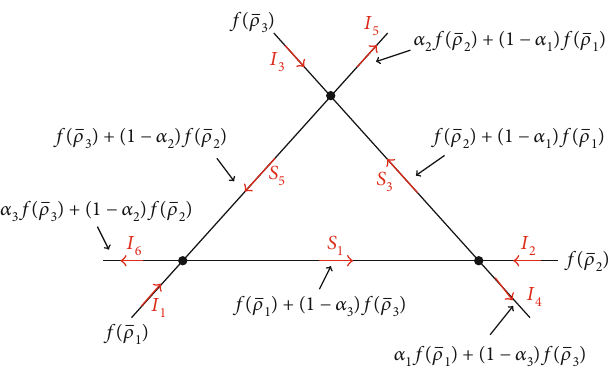
Figure 4: Free-body diagram sketch for tra ffi c at equilibrium